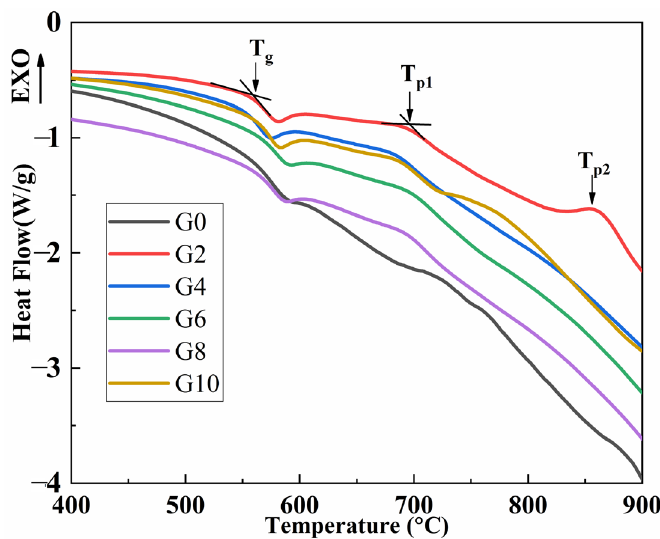
Figure 4. The DSC curves of yttrium phosphate glasses.